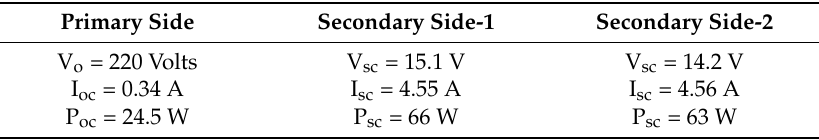
Table 1. Readings from open-circuit and short-circuit test.